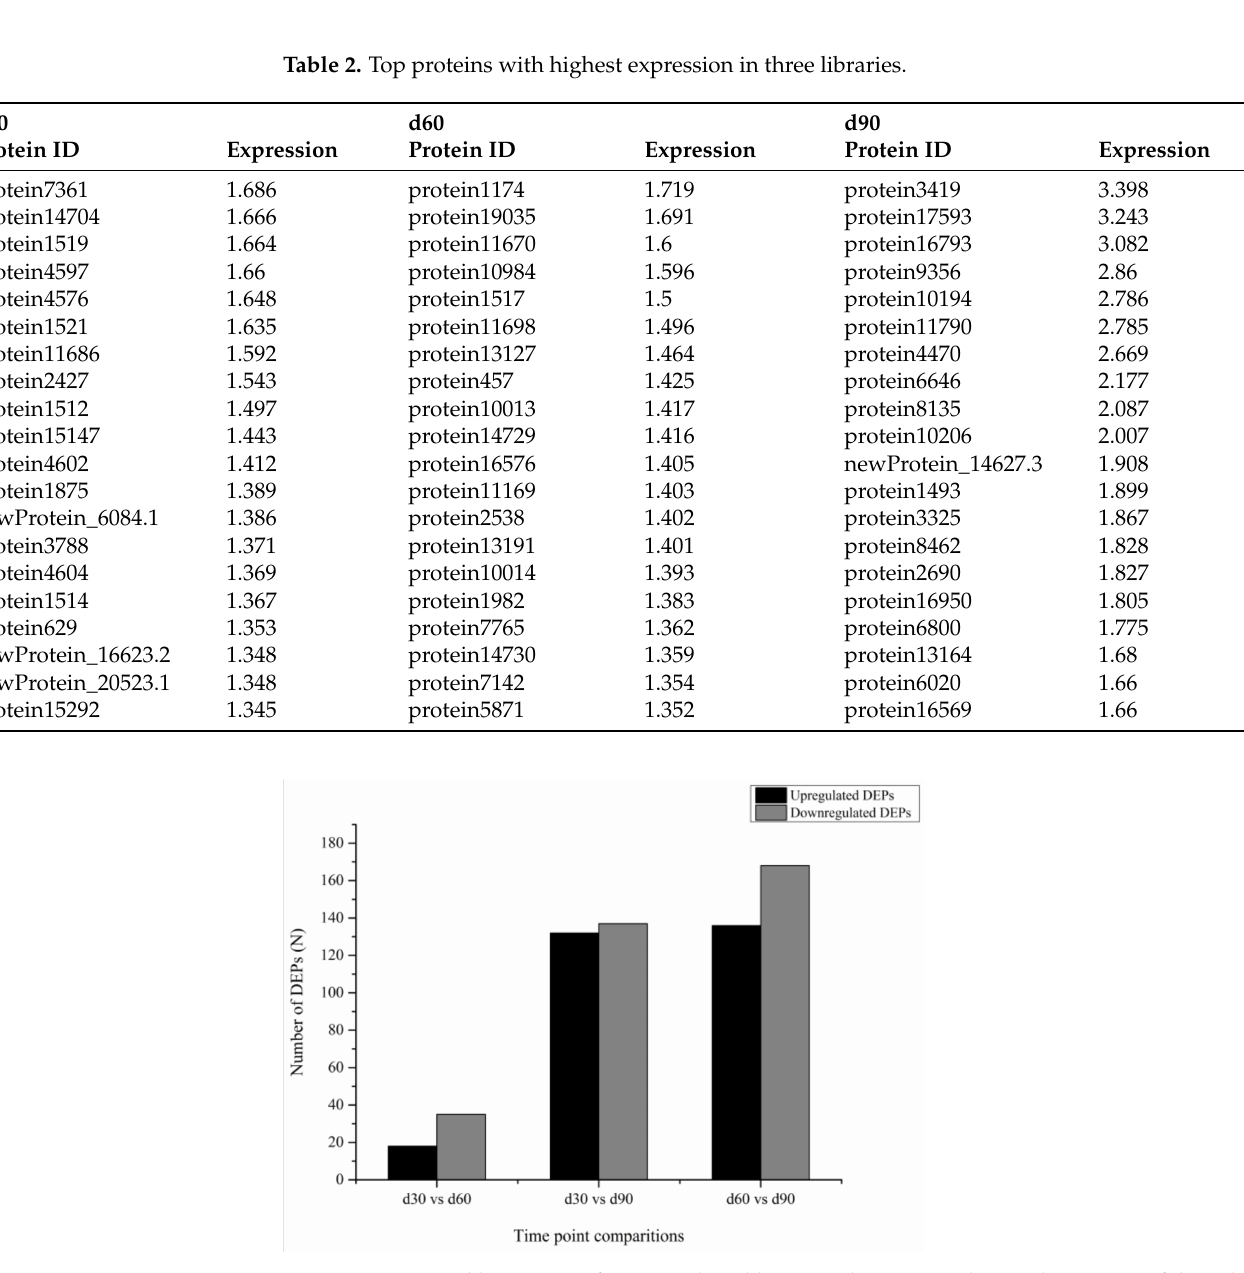
Figure 6. Statistical histogram of DEPs in three libraries. The DEPs in the cartilage tissue of the velvet antler at three time points were analyzed. There were more downregulated DEPs than upregulated DEPs in the 30 d vs. 60 d, 30 d vs. 90 d, and 60 d vs. 90 d